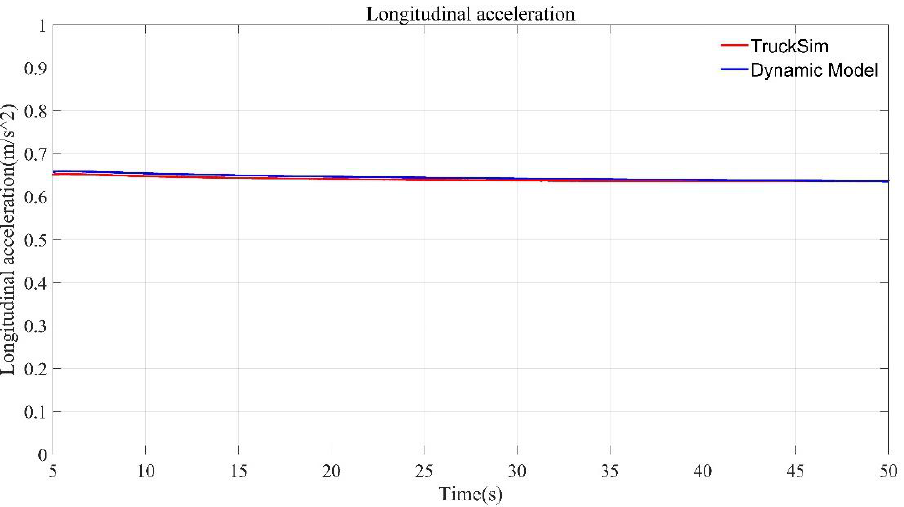
Figure 15. Comparison of the longitudinal acceleration output by the dynamics model using estimation results and TruckSim model.